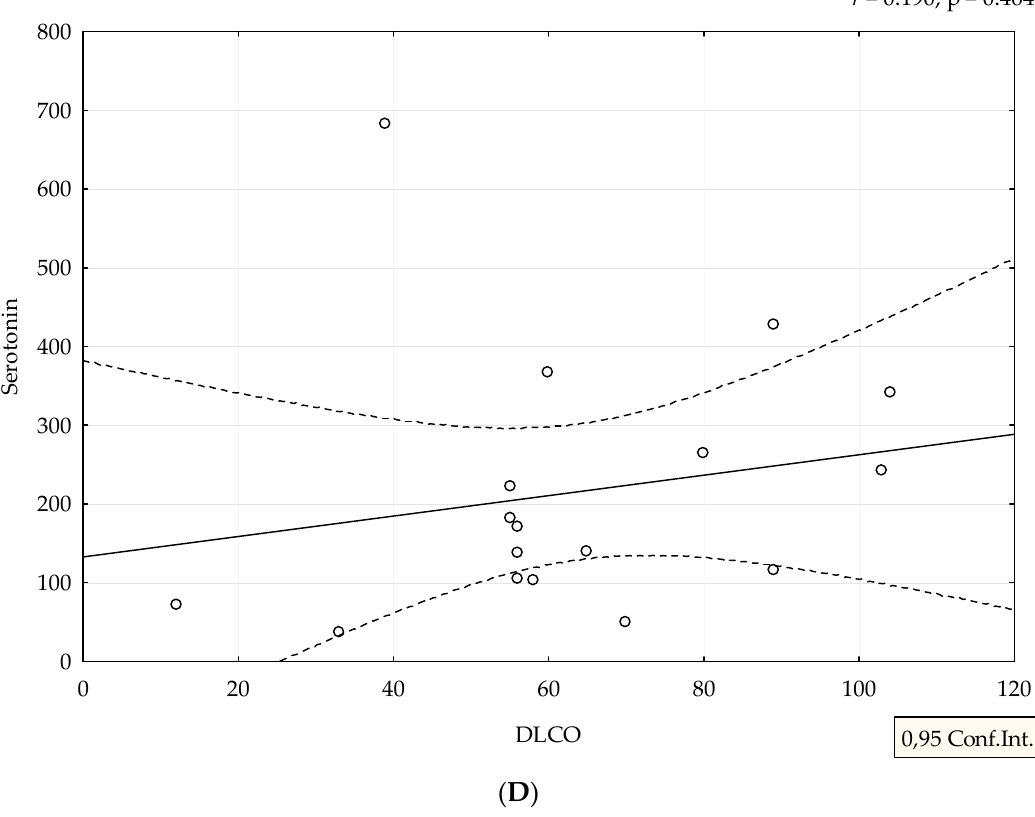
Figure 3. Correlation between spirometry parameters and serotonin levels. Serotonin is expressed as ng/mL. Spirometry parameters ( A , B , D ) (FVC, FEV1, and DLCO) are expressed as percentage, and ( C ) FEV1/FVC ratio as a number. Figures were created in Statistica 12.